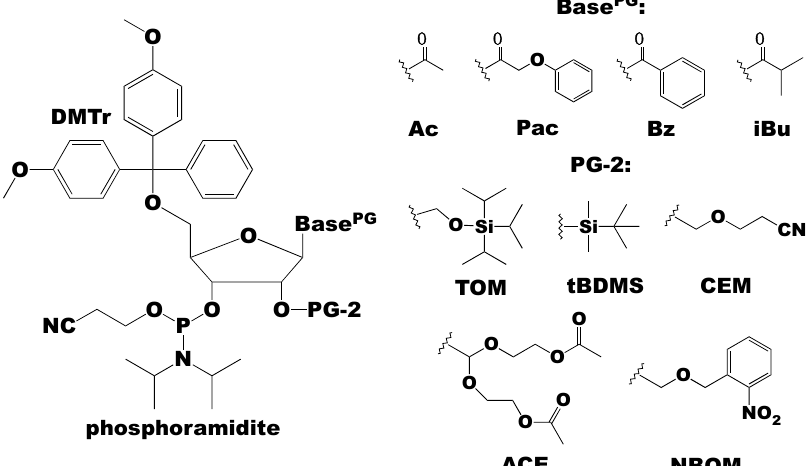
Figure 3. The phosphoramidite building blocks can have different nucleobase (exocyclic amino) and 2 ′ -OH protecting groups (PG and PG-2, respectively). Common nucleobase protecting groups are acetyl (Ac), phenoxyacetyl (Pac), benzoyl (Bz), and isobutyryl (iBu). The different 2 ′ -OH protecting groups are discussed throughout this review, but common groups include [(triisopropylsilyl)oxy]methyl (TOM), tert-butyldimethylsilyl (tBDMS), 2 ′ -cyanoethoxymethyl (CEM), bis(acetoxyethoxy)methyl ether (ACE), and photolabile 2-nitrobenzyloxymethyl (NBOM).